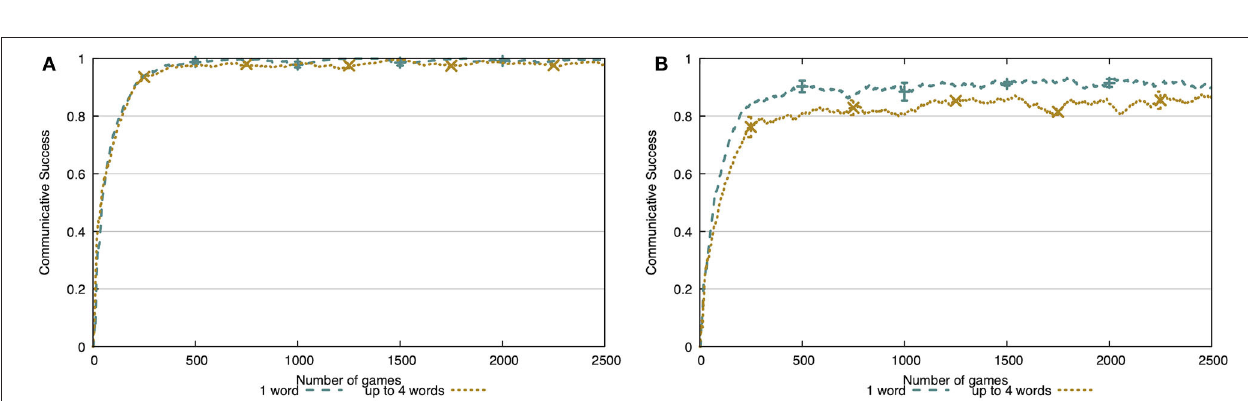
FIGURE 13 | The tutor describes 63% of the objects with a single word, 36% of the objects with two words and 1% with three words.